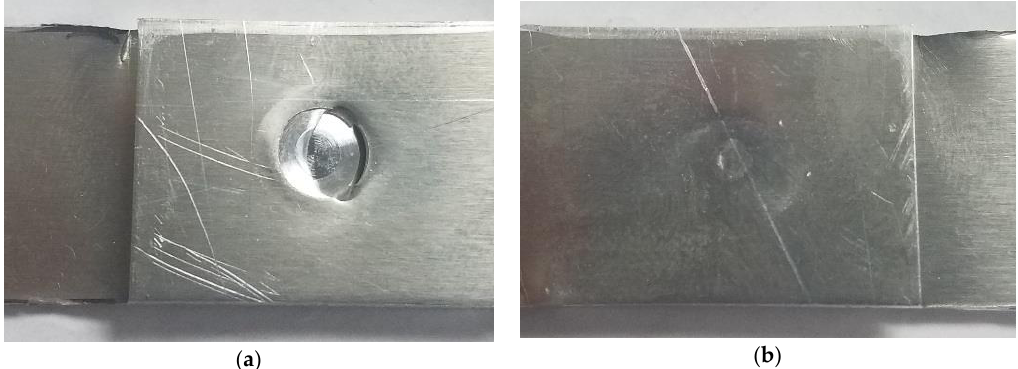
Figure 13. Nugget pullout failure of 3D-Pitch 2D-EM coupon: ( a ) top view of nugget pullout; ( b ) bottom view of nugget pullout. Notes: D = 7 mm (Spot Weld Diameter); EM = Edge Margin; pitch = Spot Weld Spacing.